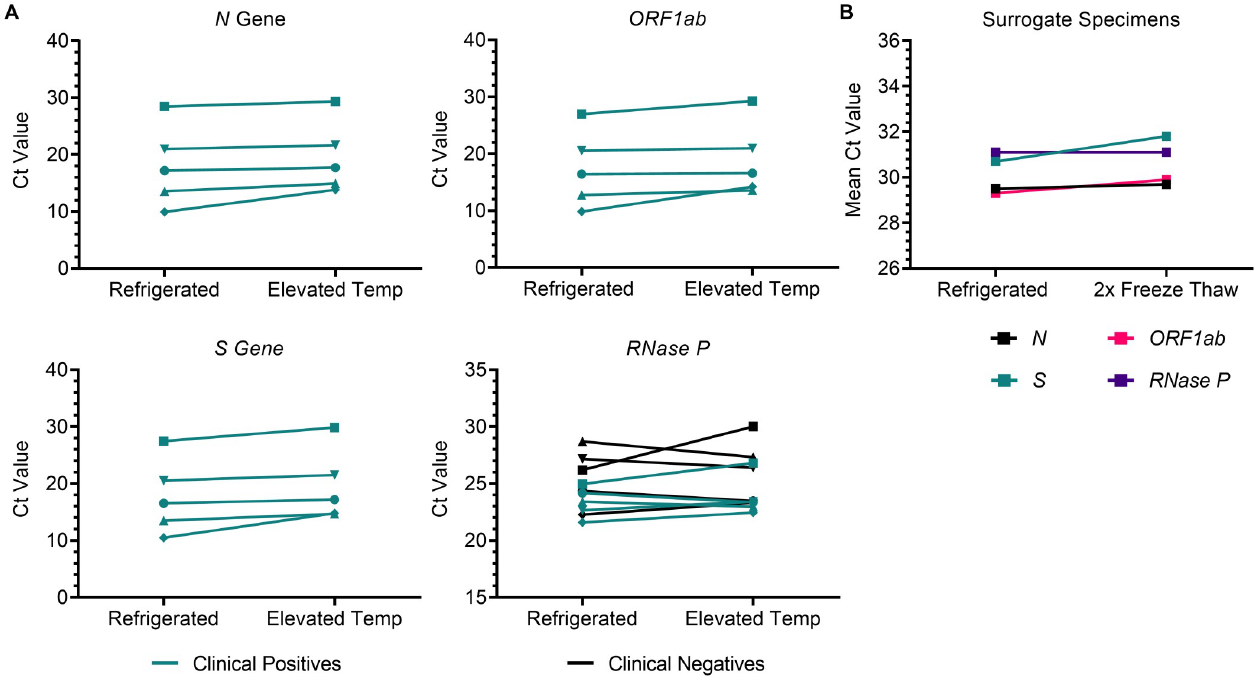
Fig 4. Clinical and surrogate dry SARS-CoV-2 specimens are stable at temperatures that mimic warm- and cold-climate shipment. (A) Paired collections from SARS-CoV-2 positive (n = 5; green) and negative (n = 5; black) patients were stored refrigerated and at elevated temperatures though 72 hours prior to RT-qPCR analysis for SARS-CoV-2 targets and RNase P . (B) Paired polyester swabs collected from human volunteers (n = 10) were spiked with the high- positive pool (10x LoD; 100 GCE/PCR reaction) and stored refrigerated or cycled through two freeze